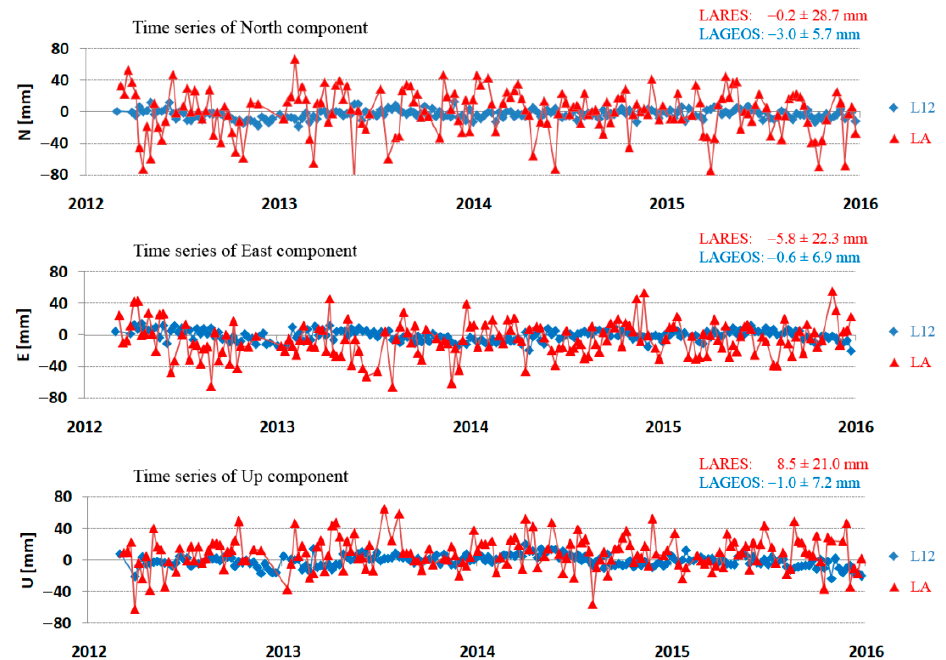
Figure 6. Time series of the North, East, and Up components for Yarragadee station (7090) for LARES (red) and LAGEOS (blue) in the period from 2012 to 2015.